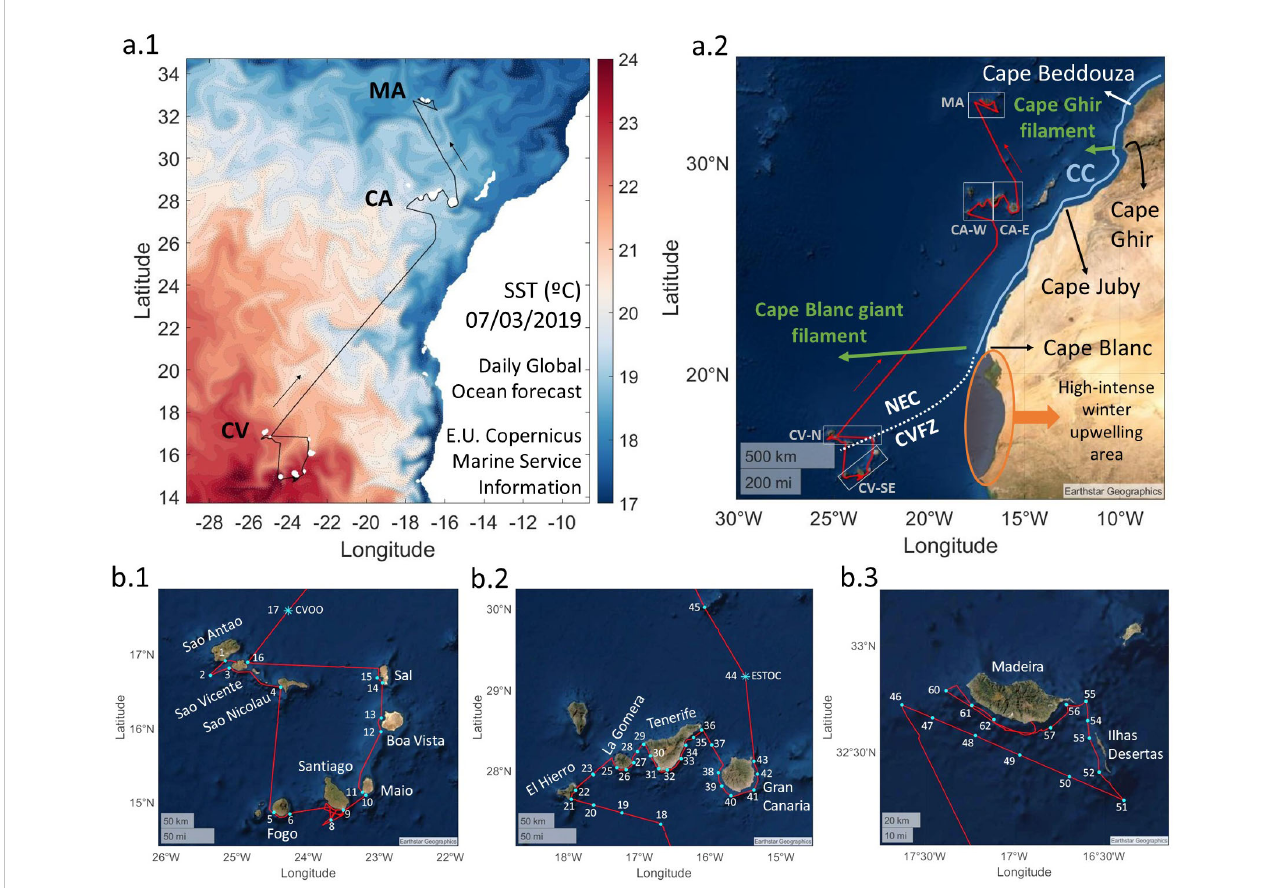
FIGURE 1 (A.1) SST map of the Macaronesian region in the Northeast Atlantic with the location of the Cape Verde (CV), Canary ( CA) and Madeira (MA) archipelagos. (A.2) Vessel track and graphical description of the oceanographic characteristics of the Macaronesian region which have a relevant role in the distribution of the biogeochemical properties. The Canary Current (CC) path and its recirculation to the southwest at Cape Blanc latitude to become the North Equatorial Current (NEC) and form the Cape Verde Frontal Zone (CVFZ) is represented (widely explained in section 2). The location of the subregions of interest in Cape Verde (northern and southeastern zones; CV-N and CV-SE, respectively) and Canary Islands (western and eastern zones; CA-W and CA-E, respectilvey) are also shown. (B) Location of the stations along the vessel track in (1) Cape Verde, (2) Canary and (3) Madeira